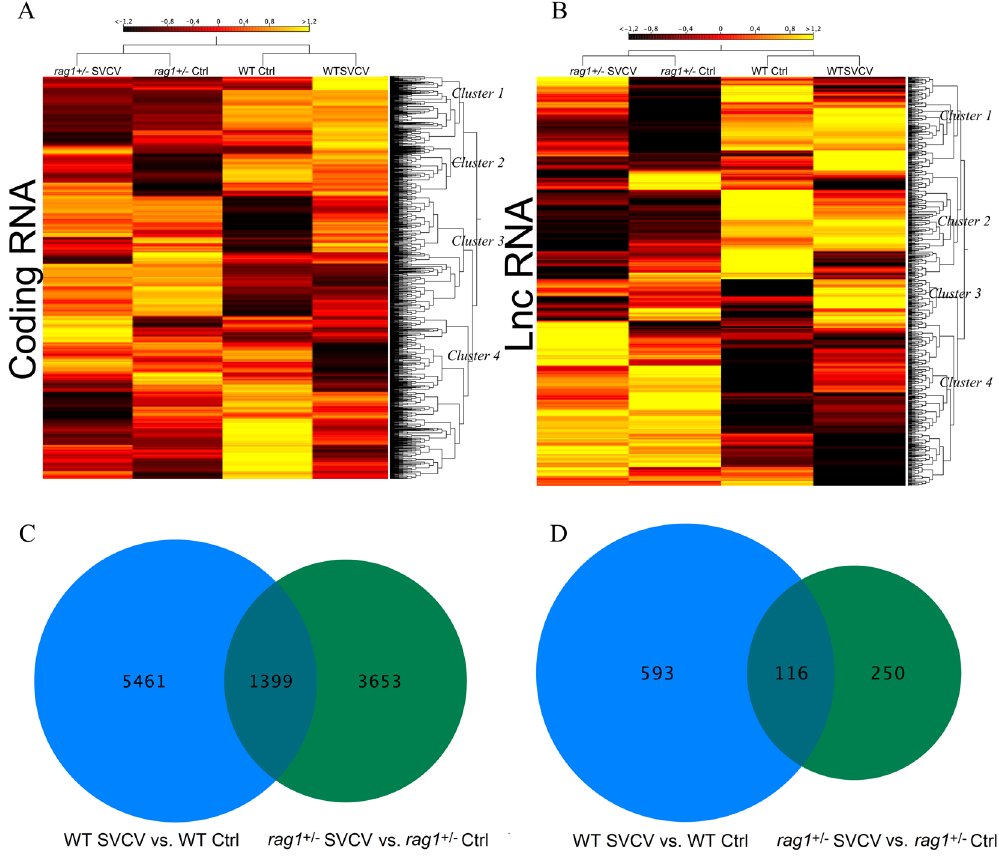
Figure 6. Differentially expressed transcripts in response to SVCV infection. ( A , B ) Hierarchical clustering of expressed transcripts (TPM values) in kidney samples from different experimental conditions. ( A ) Coding transcripts. ( B ) LncRNAs. ( C , D ) Venn diagrams representing the significantly expressed, ( C ) coding transcripts and ( D ) lncRNAs (fold-change 4, p-value